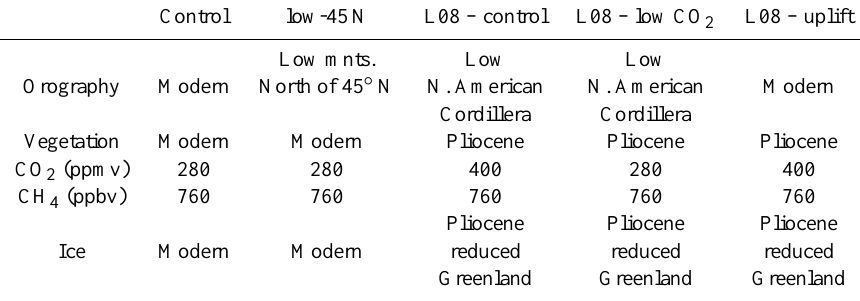
Table 1. Detail of experiments and a comparison with those of Lunt et al. (2008a). Control low-45N Low mnts. Low Low Orography Modern North of 45 ◦ N N. American N. American Modern Cordillera Cordillera Vegetation Modern Modern Pliocene Pliocene 760 760 760 760 760 Pliocene Pliocene Pliocene Ice Modern Modern reduced reduced reduced Greenland Greenland